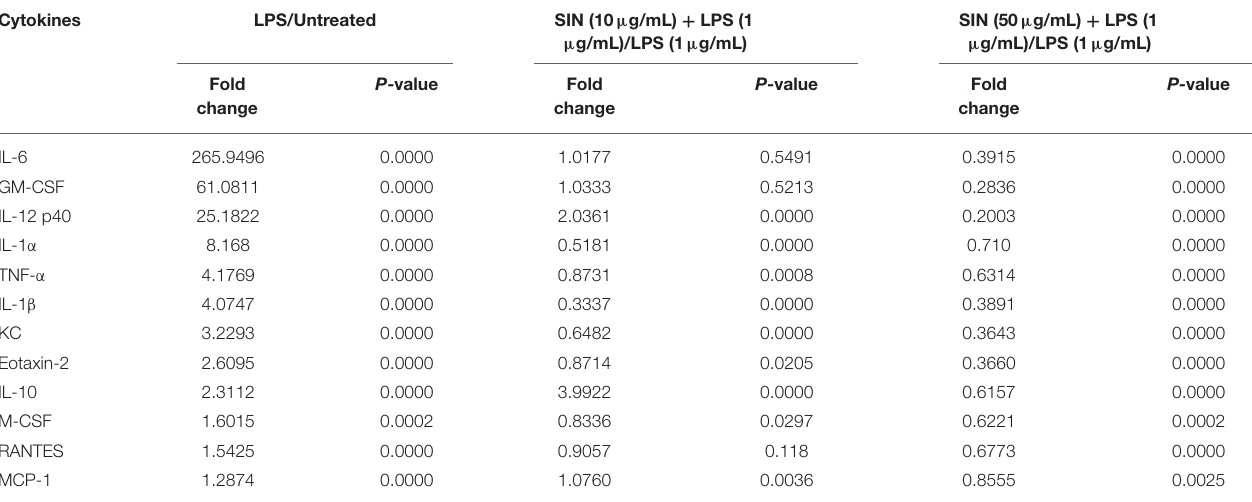
TABLE 1 | LPS-induced and SIN reversed target cytokines in inflammatory cytokine array ( n = 4, P < 0.05). Cytokines